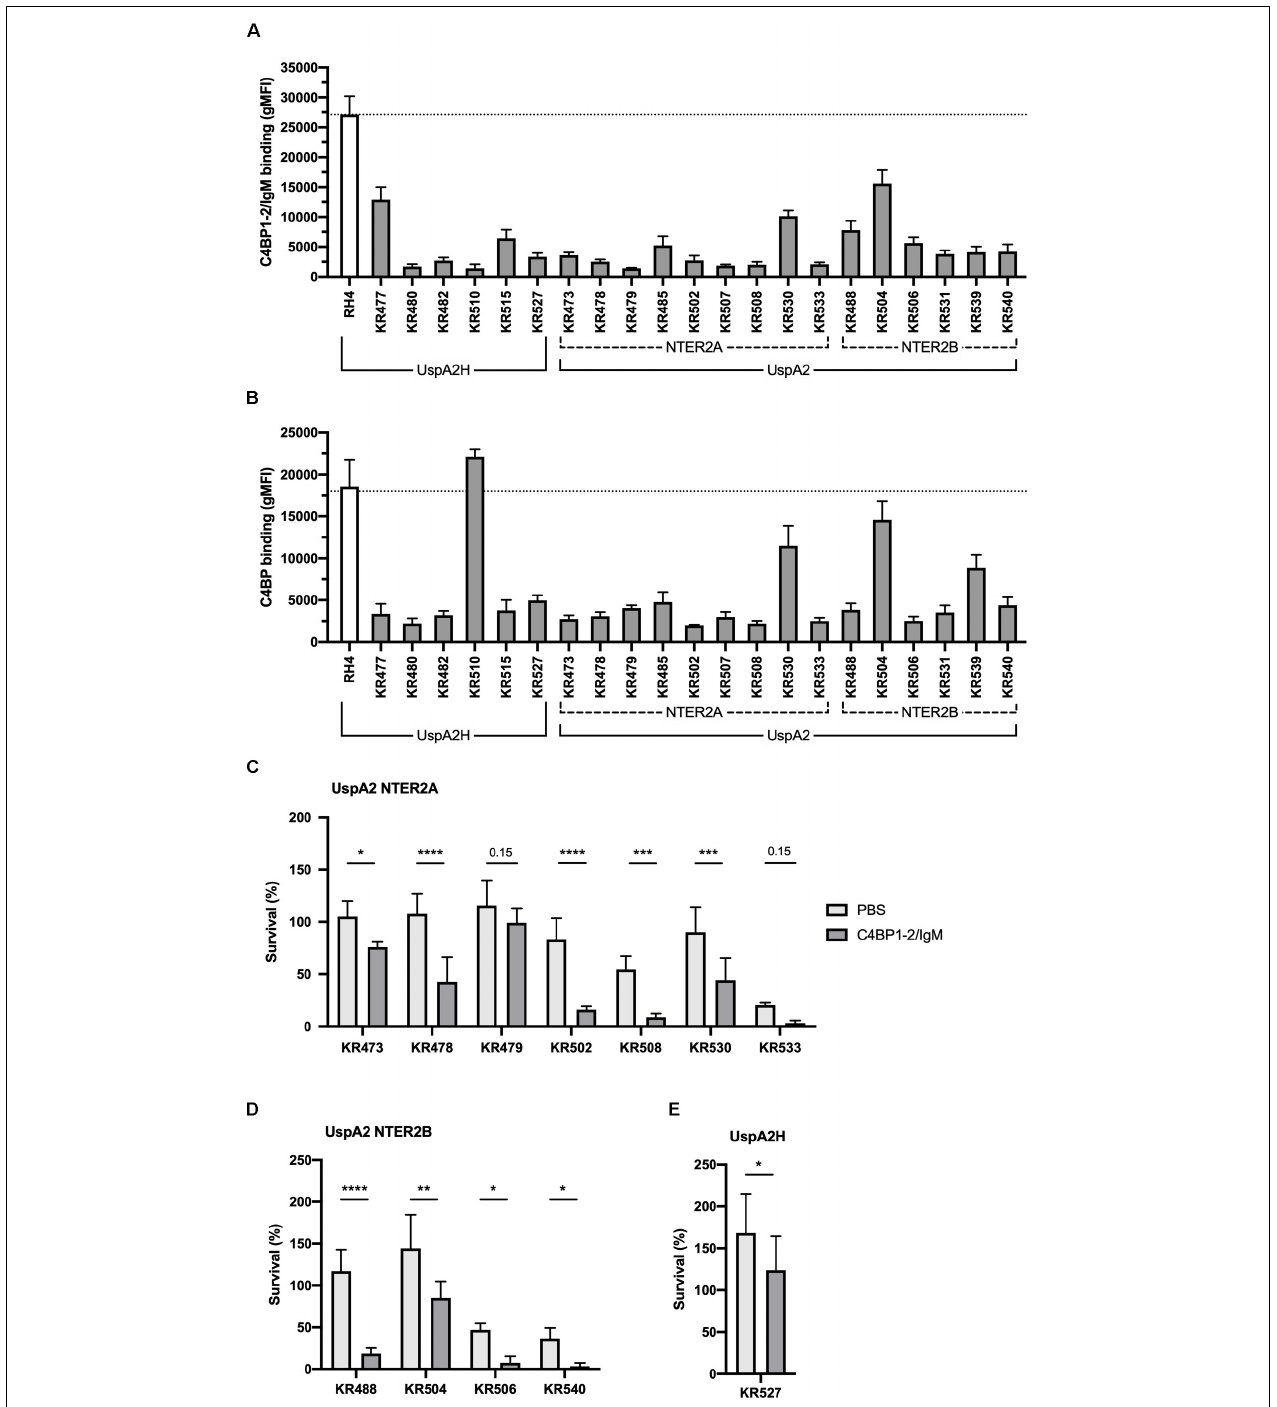
FIGURE 7 | C4BP1-2/IgM binds to and increases serum killing of many of the M. catarrhalis clinical isolates tested. (A) 21 clinical isolates and the lab strain RH4 were tested for C4BP1-2/IgM binding by flow cytometry. The gMFI for control without C4BP1-2/IgM was similar in all isolates (average 152, SD 75). (B) Clinical isolates were tested for C4BP binding from NHS by flow cytometry. Moraxella isolates were treated with 5% NHS + OmCI for 30 min. The gMFI for control without NHS was similar in all isolates (average 207, SD 132). (C–E) Twelve clinical isolates were treated with 50 µ g/ml of C4BP1-2/IgM or PBS, before addition of as 15% NHS, and their survival after 30 min was assessed by plating bacteria and counting remaining CFU. The remaining nine isolates were not included because their survival in serum in the absence of fusion protein was less than 5%. (C) UspA2 NTER2A strains, (D) UspA2 NTER2B strains, (E) UspA2H strains. Mean ( ± SD) from three (A) or four (B–E) independent experiments are shown. Statistical significance of differences was calculated using two-way ANOVA with Holm–Sidak’s post-test; * p < 0.05; ** p < 0.01; *** p < 0.001; **** p < 0.0001.